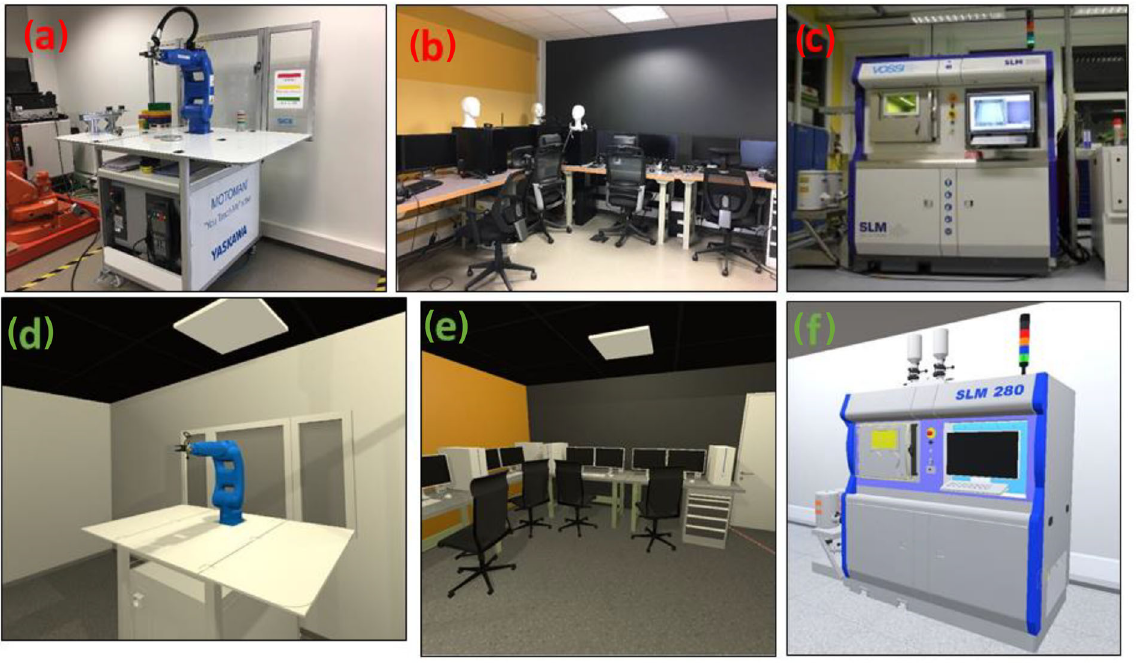
Fig. 1. Digitalized laboratories – Flexible Manufacturing Systems, Robotics Demo Centre, and ProtoLab (a, b, c – real; d, e, f –